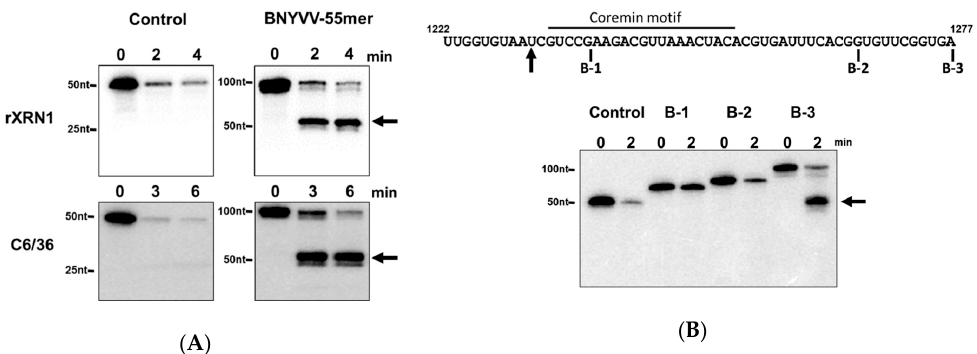
Figure 5. A 55 nt fragment containing the coremin motif is sufficient to stall XRN1. ( A ) 5 ′ monophosphorylated radiolabeled RNA substrates containing either control sequences derived from pGEM-4 or a 101-nt RNA containing a 55 base fragment from the RNA3 segment of BNYVV (nts 1222–1277) at the 3 ′ end and 53 nts of pGEM-4 polylinker sequence at its 5 ′ end to serve as a landing site for 5 ′ -to-3 ′ exonucleases) were incubated with either purified recombinant XRN1 from Kluyveromyces lactis (rXrn1 panel) or cytoplasmic extract from C6/36 Aedes albopictus cells for the times indicated. Reaction products were resolved on a 5% acrylamide gel containing urea and viewed by phosphorimaging. ( B ) Top: sequence of the 55 nts BNYVV RNA fragment. The black arrow indicates the site of XRN1 stalling. Fragments B-1, B-2, and B-3 containing BNYVV-specific sequences ranging from position 1222 to the base indicated in the figure. Bottom: 5 ′ monophosphorylated radiolabeled RNA substrates containing either control sequences derived from pGEM-4 or the B-1, B-2, or B-3 fragments of the RNA3 segment (nts 1222–1277) as indicated in the top part of the panel (inserted into the pGEM-4 polylinker as indicated in panel A) were incubated with purified recombinant XRN1 for the times indicated. Reaction products were resolved on a 5% acrylamide gel containing urea and viewed by phosphorimaging. Arrows indicate the positions of the RNA species stalling